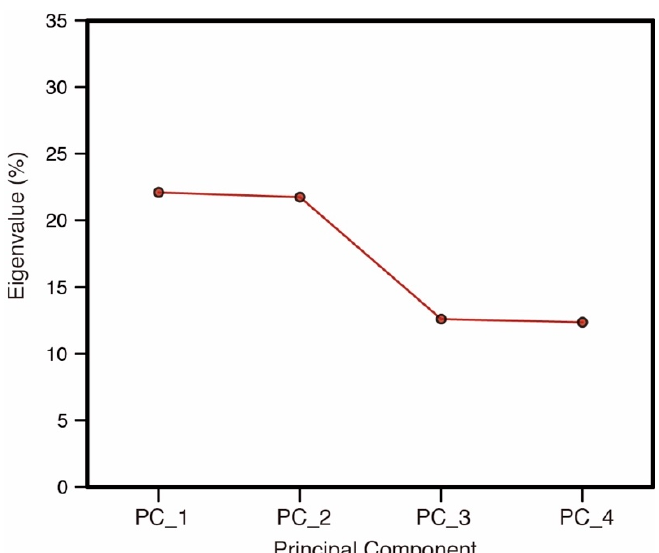
Figure 23. Eigenvalue of each principal component.